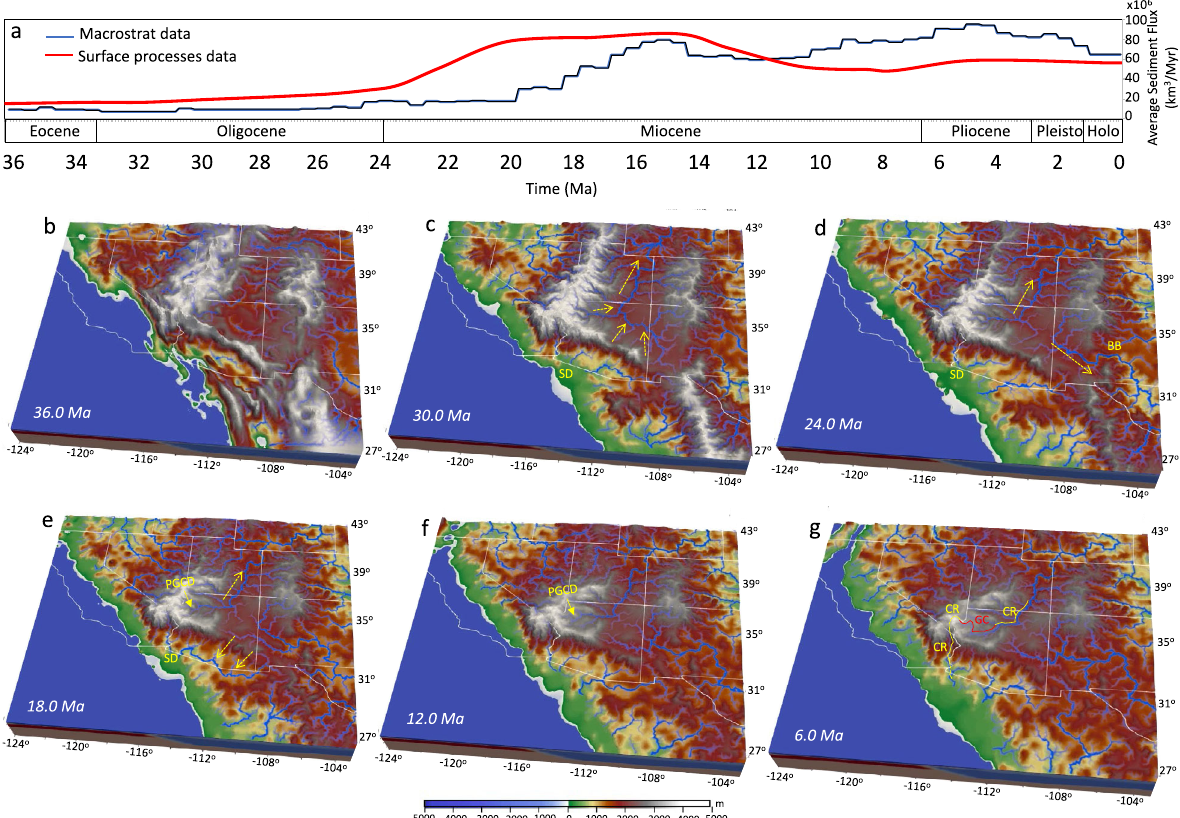
Fig. 10 Interaction and interconnection between tectonics, climate, and surface processes. a Dark blue line represents the average sediment fl ux within the Basin and Range Province based on the palinspastically restored history of sediments from Macrostrat since the late Eocene. Red line represents simulated average sediment fl ux within the Basin and Range Province based on surface processes simulations from the late Eocene to present. b – g Simulated paleo-elevation and drainage in southwestern North America at 36, 30, 24, 18, 12, and 6 Ma, respectively. Panel ‘ c ’ shows north and northeast drainage onto the Colorado Plateau from the Nevadaplano and Mogollon Highlands. Panel ‘ d ’ shows a drainage reversal to the south. Panel ‘ e ’ shows drainage out of the Colorado Plateau to the southwest. SD Sespe Delta, PGCD Paleo Grand Canyon Drainage, GC Grand Canyon, CR Colorado River, BB Baca Basin. The map images were created by authors using: www.soest.hawaii.edu/gmt/ and